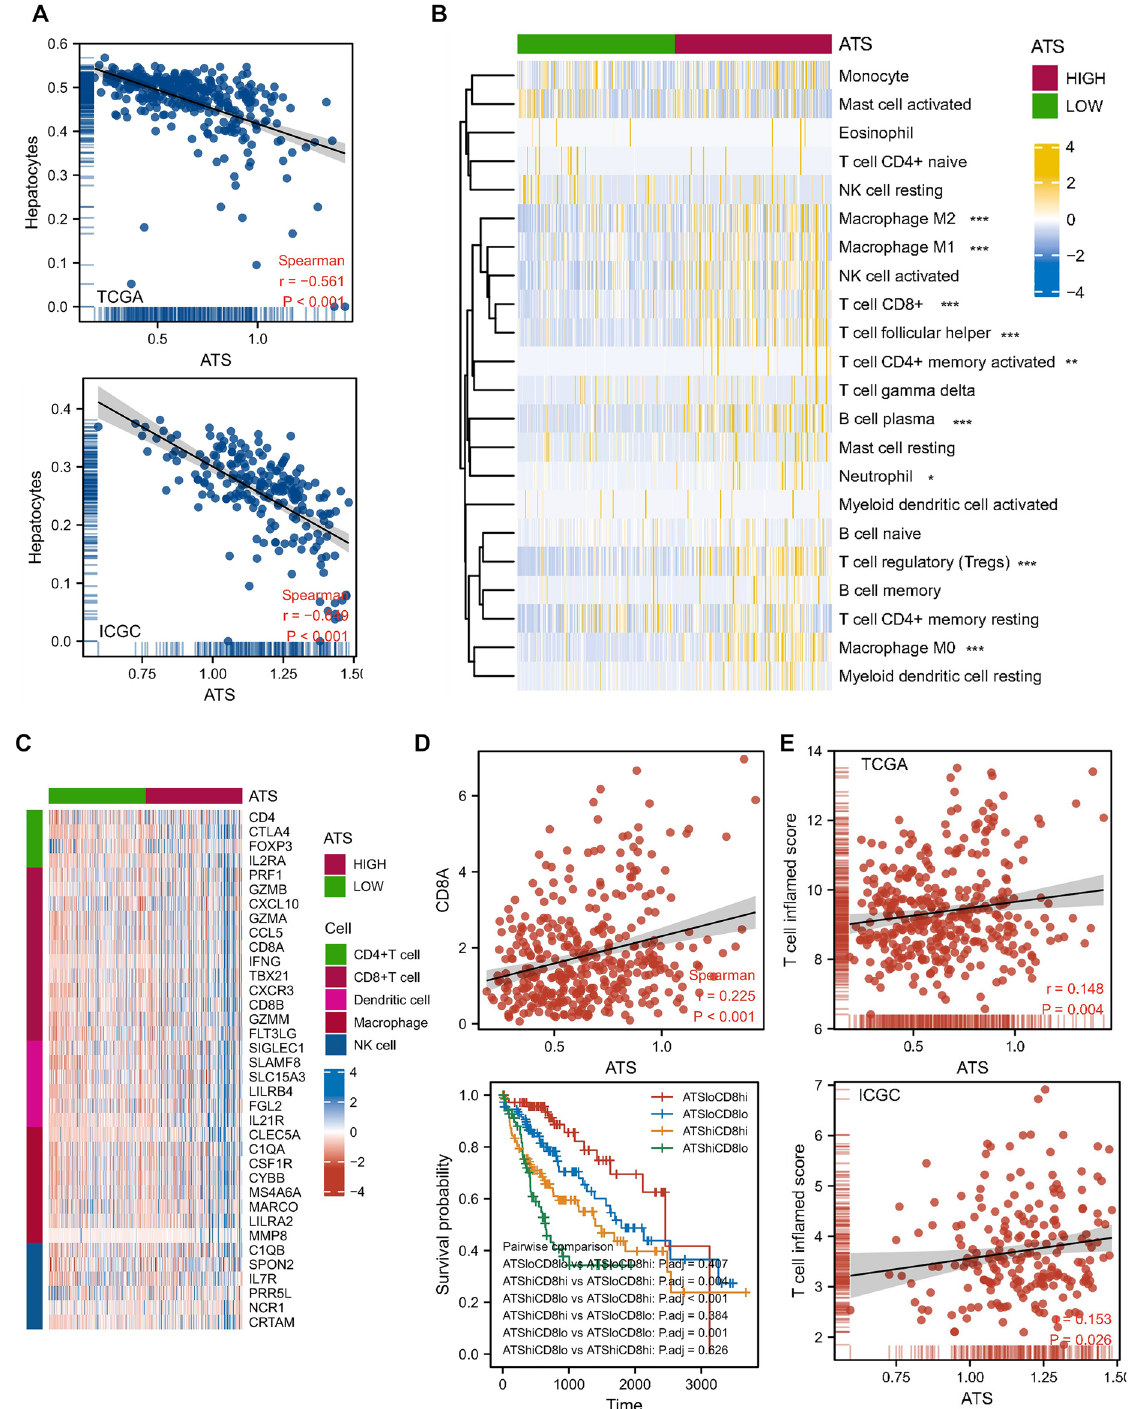
Figure 5. The ATS signature is associated with an inflamed TME. ( A ) Correlations between ATS and the hepatocyte enrichment. ( B ) TME cell proportions in ATS subgroups. ( C ) Positive correlation between the ATS signature and marker genes of immune cells. ( D ) Correlation between the ATS signature and CD8A expression, and the ATS-associated CD8+ T cell survival plot. ( E ) Correlations between ATS and TIS score in TCGA and ICGC cohorts,